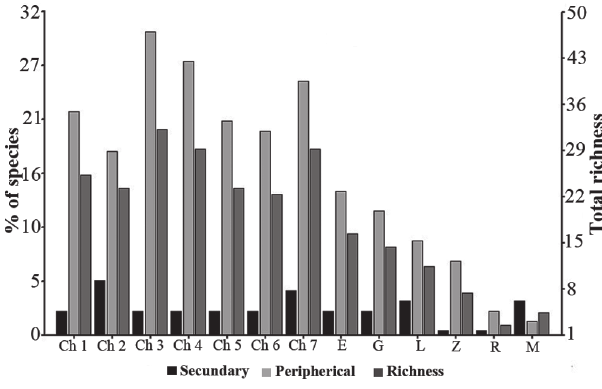
Fig. 3. Ecological composition of fishes in Chacmochuch Lagoon System and total richness, secondary and peripherical species are